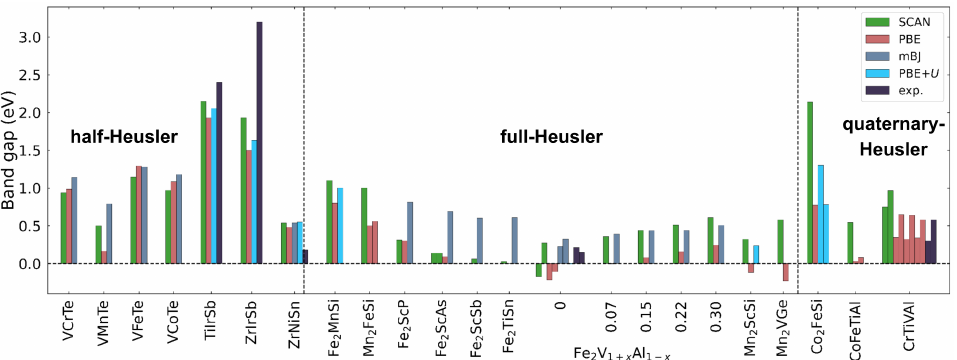
Figure 24. The band gap width for a set of Heusler alloys calculated by PBE, SCAN and mBJ [63,64,108,111–116,118,137,165–169]. The band gap widths calculated by PBE + U were taken from Refs. [155,170–174]. The available experimental values were taken from the mentioned papers. In addition, the following Refs. were used to collect experimental data: TiIrSb and ZrIrSb [175], ZrNiSn [176], Fe 2 VSi [177], Fe 2 VAl [178], CrTiVAl [179]. A negative gap value indicates metallic behavior due to the greater energy of VBM compared to that of CBM (see Equation